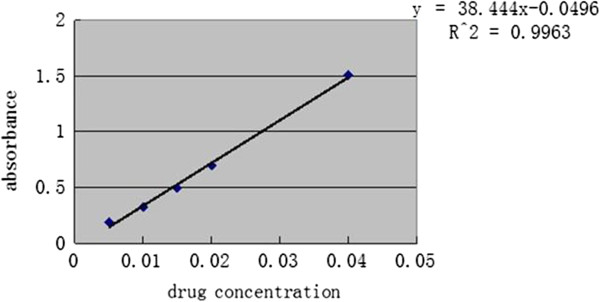
The standard curve of emodin by UV method.